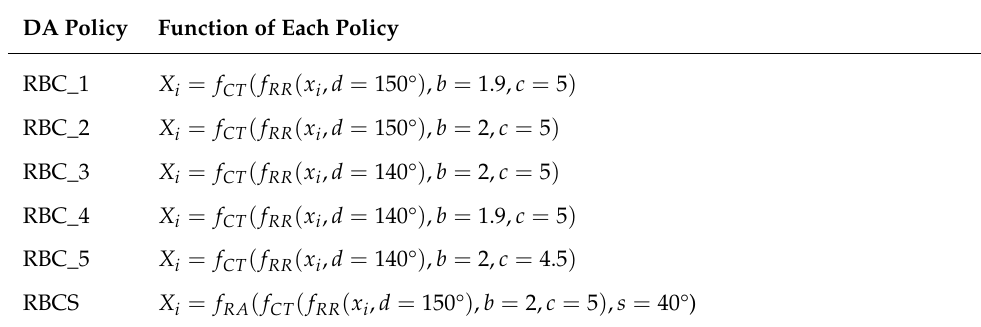
Table 10. DA combination